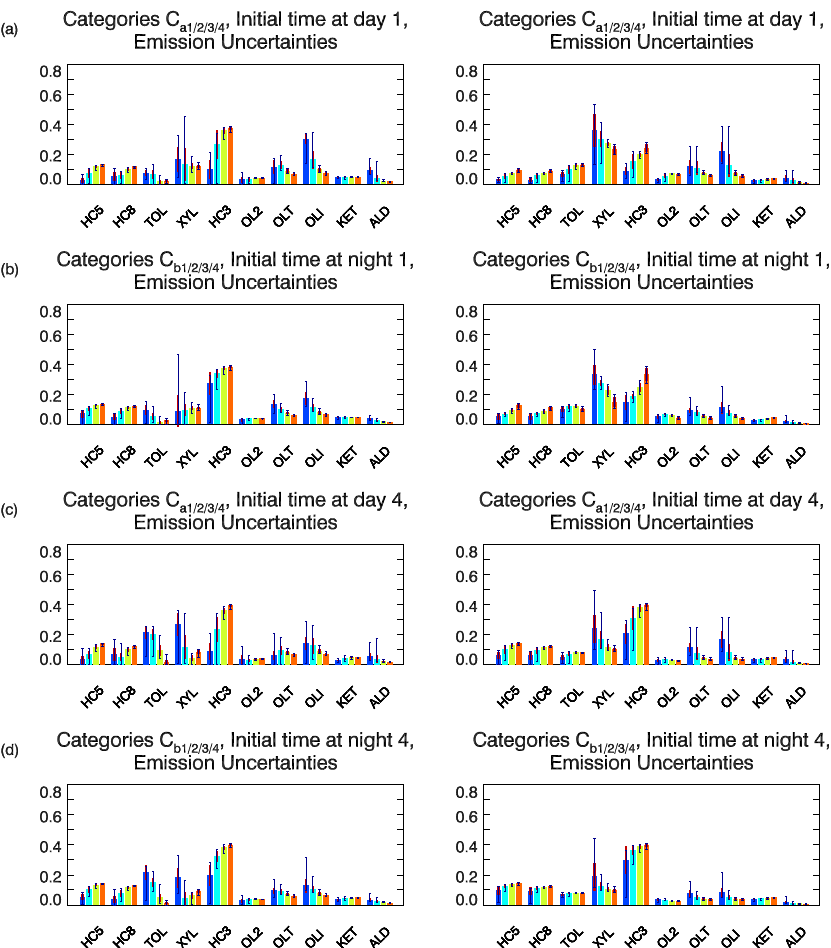
Fig. 7. Statistics of optimal projected relative singular vectors with respect to emission uncertainties for scenario PLUME (left panel column) and scenario URBAN (right panel column) for (a) day 1, (b) night 1, (c) day 4, and (d) night 4. Displayed are results for categories C a and C b for the VOCs with the most influence. All panels depict mean impact ( C a 1 /b 1 : blue bars, C a 2 /b 2 : turquoise bars, C a 3 /b 3 : green bars, C a 4 /b 4 : orange bars), minimum/maximum value (dark blue lines) and standard deviation (red bars).